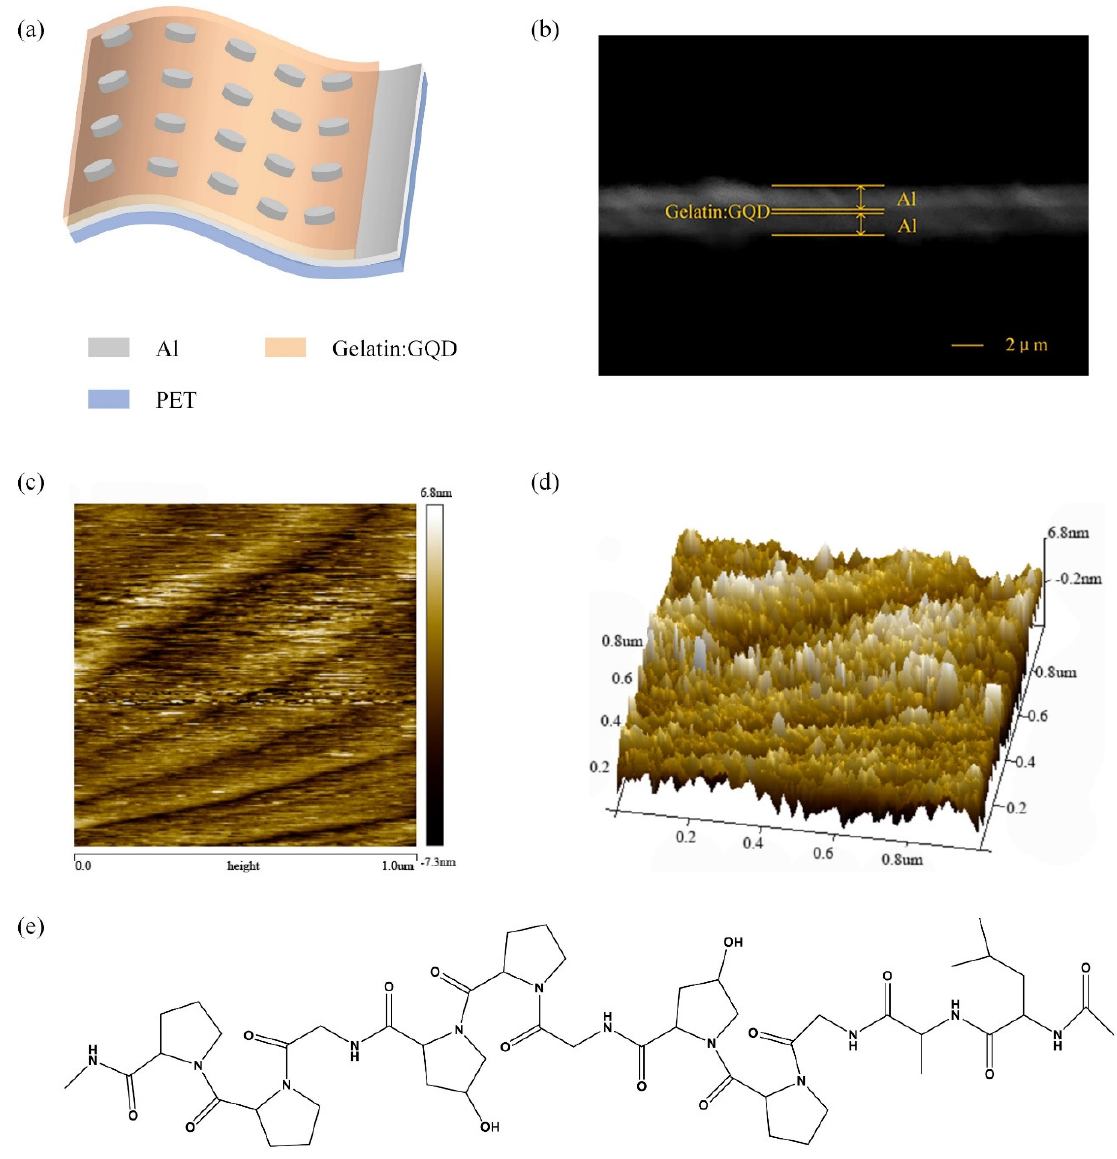
Figure 1. Device Al/Gelatin:GQD/Al/PET: ( a ) structure diagram and ( b ) SEM image of a cross-section. AFM images of the active layer: ( c ) two-dimensional and ( d ) three-dimensional. ( e ) Schematic diagram of the partial structure of the peptide chain in gelatin.